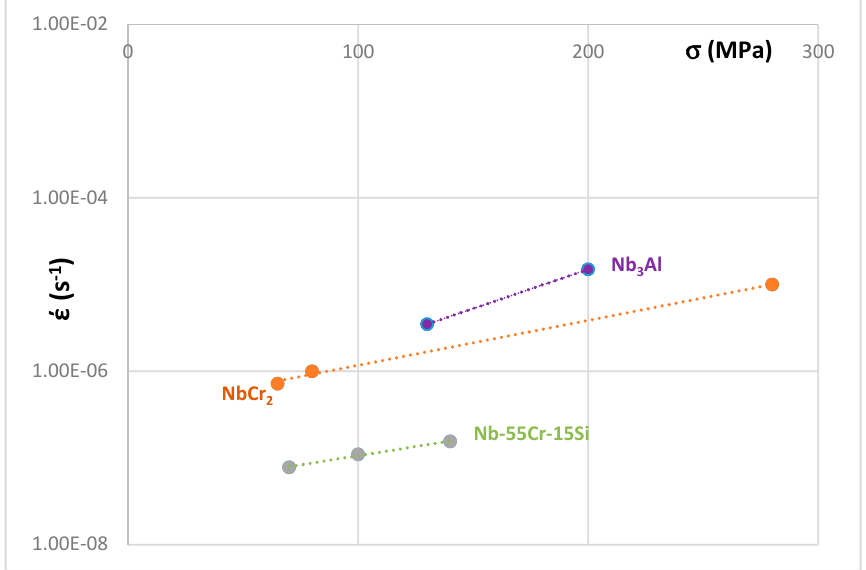
Figure 9. Norton plot of creep rate (s − 1 ) versus stress (MPa) at 1473 K of unalloyed and Si alloyed Laves phases [18,52] and unalloyed A15–Nb 3 Al [18]. The former are shown in the ∆χ versus VEC maps in Figure 2a,b and the latter in the map in Figure 6 (see text).